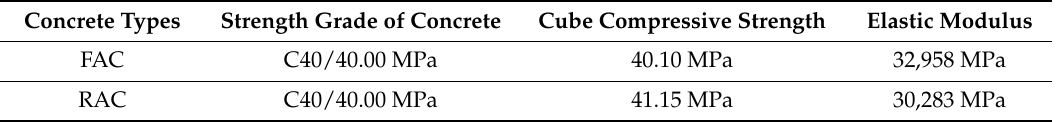
Table 4. Test results of cube compressive strength of fine aggregate concrete (FAC) and RAC concrete cube